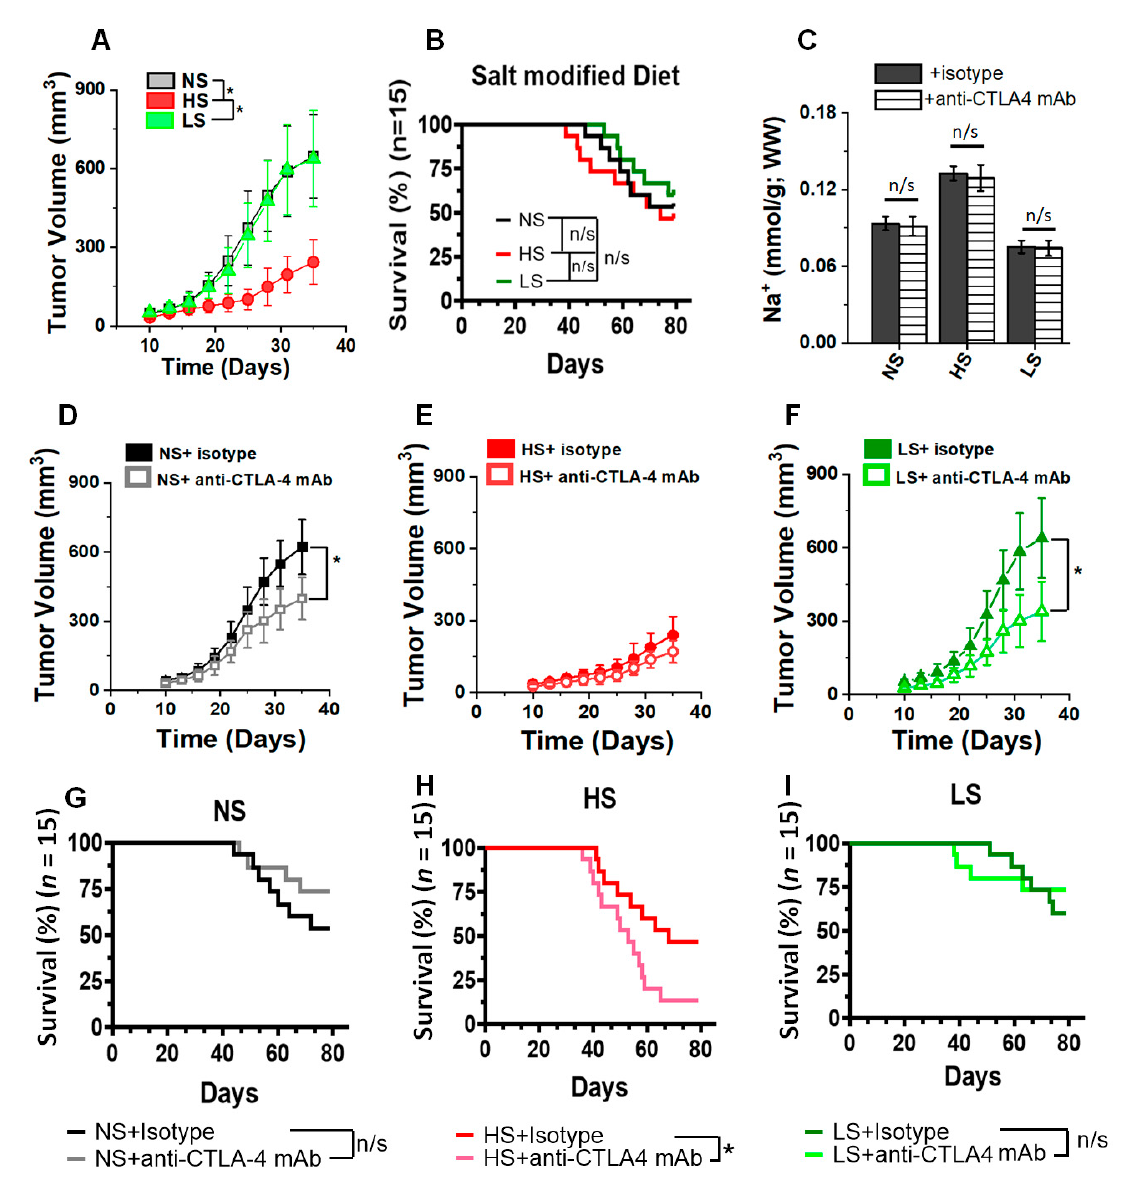
Figure 2. Tumor volume kinetics and survival analysis following salt-modified diet. ( A ) Tumor volume changes following dietary salt modification (NS, normal/regular salt; HS, high salt; LS, low salt); tumor volume kinetics followed for 5 weeks. Data presented as mean ± SEM, n = 8, statistical analysis was performed using two-way ANOVA multiple comparisons, Dunnet’s post-test (*) p -value < 0.05. ( B ) Survival rate in the three salt modified diet cohorts, tumor-bearing mice followed for 80 days. The n = 15 per cohort, statistical analysis performed by log-rank Mantel–Cox comparison. ( C ) [Na + ] concentration in the murine breast tumors with isotype vs. anti-CTLA4 mAb treatment. Data analyzed by post hoc Bonferroni correction, n/s = not significant. ( D – F ) Tumor progression kinetics in NS ( D ), HS ( E ) and LS ( F ) cohorts following treatment with anti-CTLA4 monoclonal antibody (mAb) or isotype control with 200 µ g injected intraperitoneally (i.p.) on days 7, 10 and 13, and followed for 5 weeks. Data presented as mean ± SEM, n = 8, statistical analysis was performed using multiple t -test, (*) p -value < 0.05. ( G – I ) Survival rate analysis in NS ( G ), HS ( H ) and LS ( I ) cohorts following treatment with anti-CTLA4 monoclonal antibody (mAb) or isotype control with 200 µ g on days 7, 10 and 13, and followed for 80 days. The n = 15 per cohort, statistical analysis performed by log-rank Mantel–Cox comparison. Hazard ratio (HR) was performed by Mantel–Haenszel